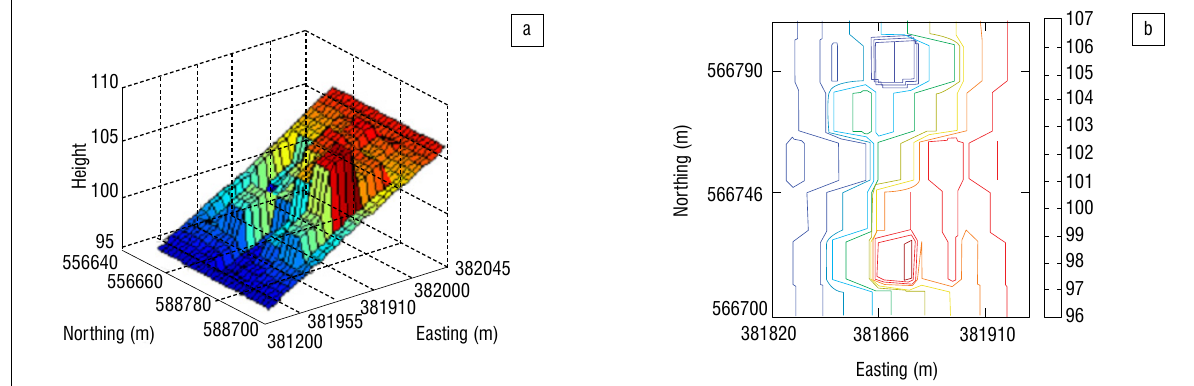
Figure 7: Nearest neighbour method (a) digital terrain model plot and (b) contour plot.